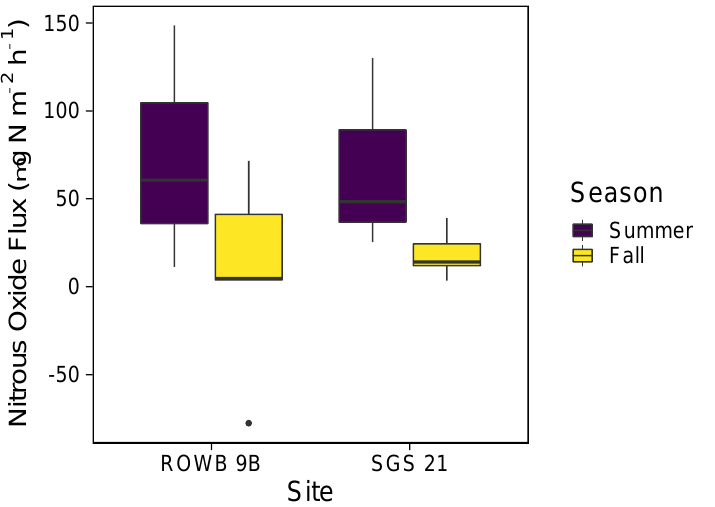
Figure 9. Soil nitrous oxide gas emissions ( n = 16).